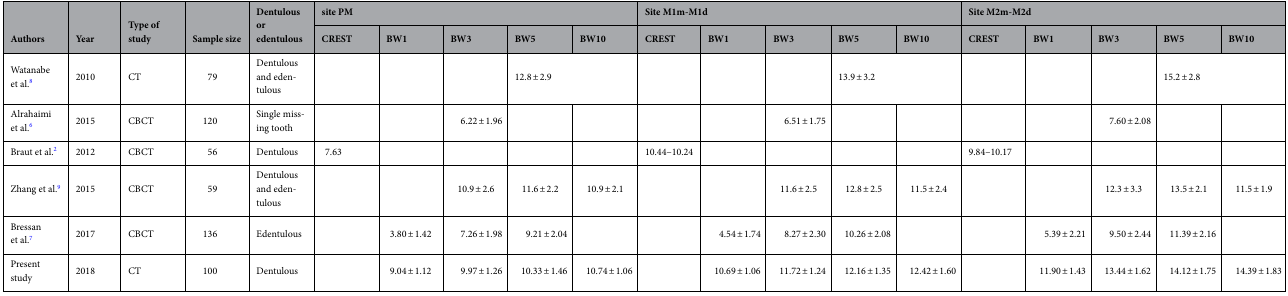
Table 7. Comparison of bone width (BW) values in the literature.